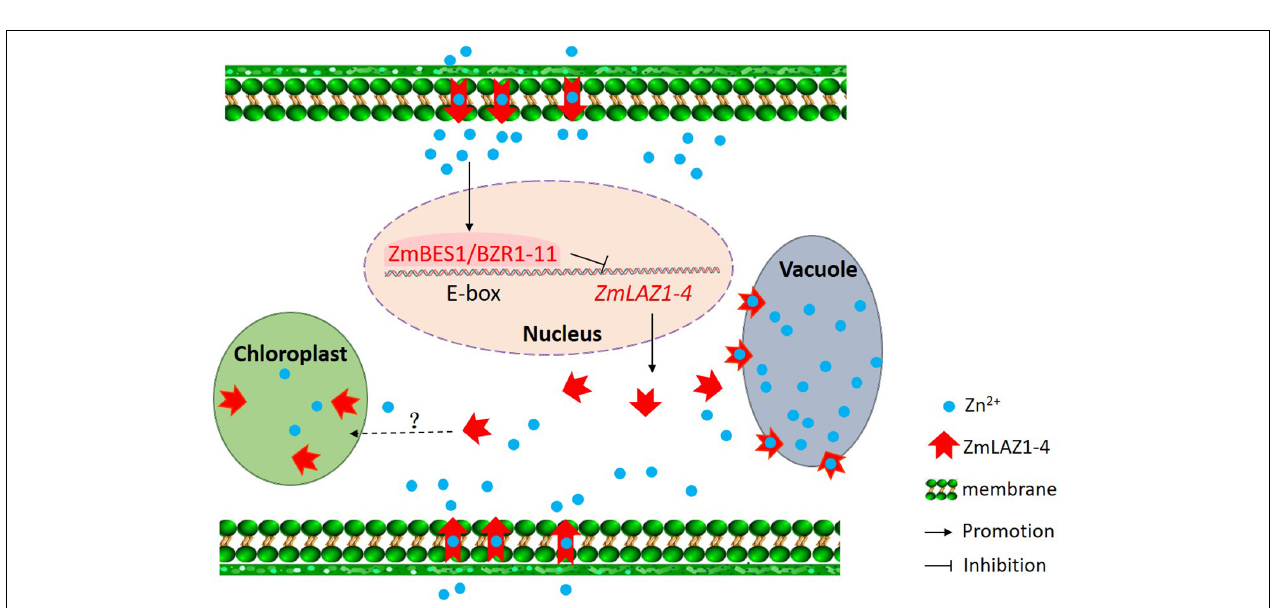
FIGURE 8 | Signaling diagram of zinc homeostasis in maize. The black words, lines, and arrows indicate signaling pathways previously reported. The red words, lines, and arrows show signaling pathway demonstrated in the